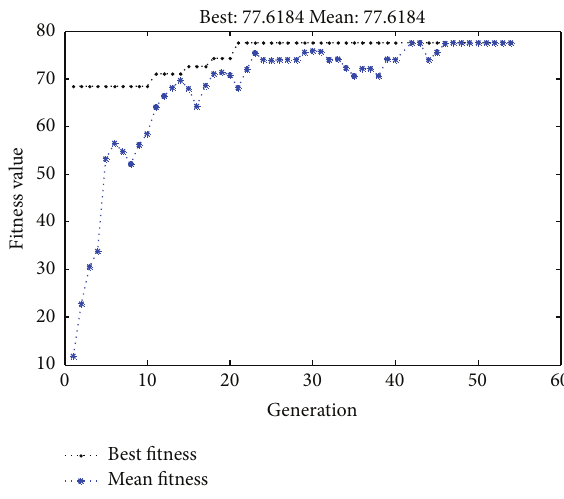
Figure 15: Fitness value considering friction variable as objective function.